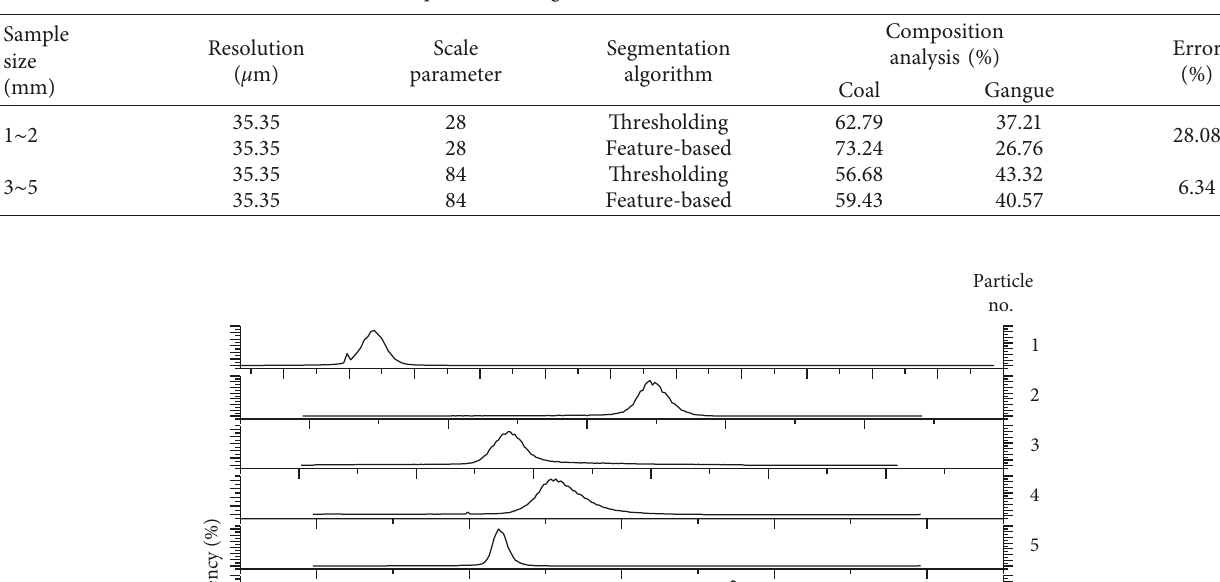
Figure 5: Segmentation results for the small-scale CT image and the artificial image based on the feature-based algorithm. This figure (a) presents the small-scale CT image and (b) presents the artificial image. Table 1: Comparison for segmentation and validation results of CGPs.